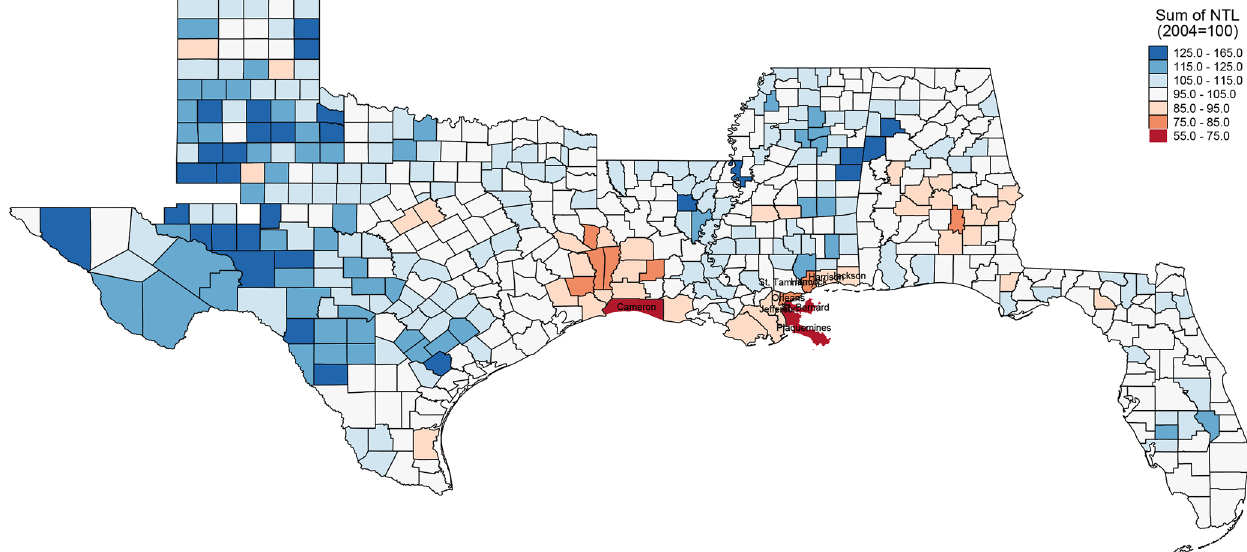
Figure A4. Change in light intensity in 2005, including all states affected by hurricanes Katrina, Rita, and Wilma. Night light reduction by county between 2004 and 2005, with the sum of light intensity indexed to 2004 = 100. Values below 100 indicate a reduction in light intensity with respect to 2005, while values above 100 indicate an increase. Based on own calculations. Sum of night light is based on calibrated light series using the Elvidge et al. (2014) method, discussed in detail in Sect. 2.3. Note that the pattern for Hurricane Rita is similar to that of Hurricane Katrina in terms of damages and reduction in night light intensity reductions. In line with a lower degree of housing damage due to Hurricane Wilma in the south of Florida, we do not observe major reductions in light intensity